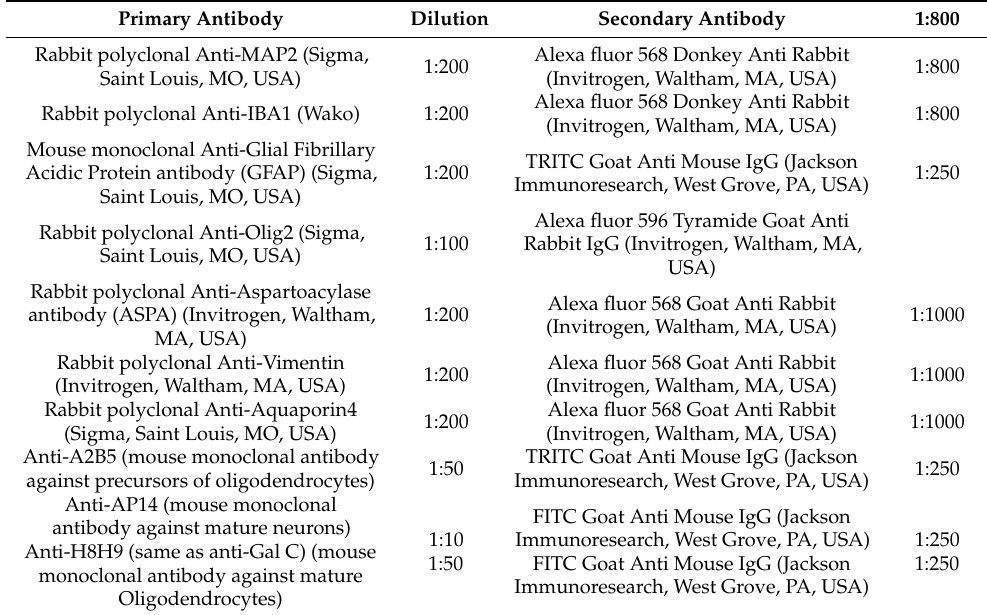
Table 1. Antibodies and respective dilutions used for immunofluorescence. Primary Antibody Dilution Secondary